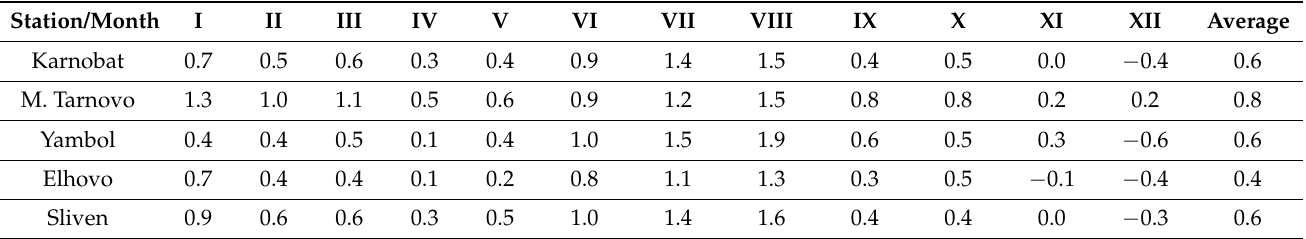
Table 5. Average monthly temperatures deviations in southeastern Bulgaria in the period 1986–2015.